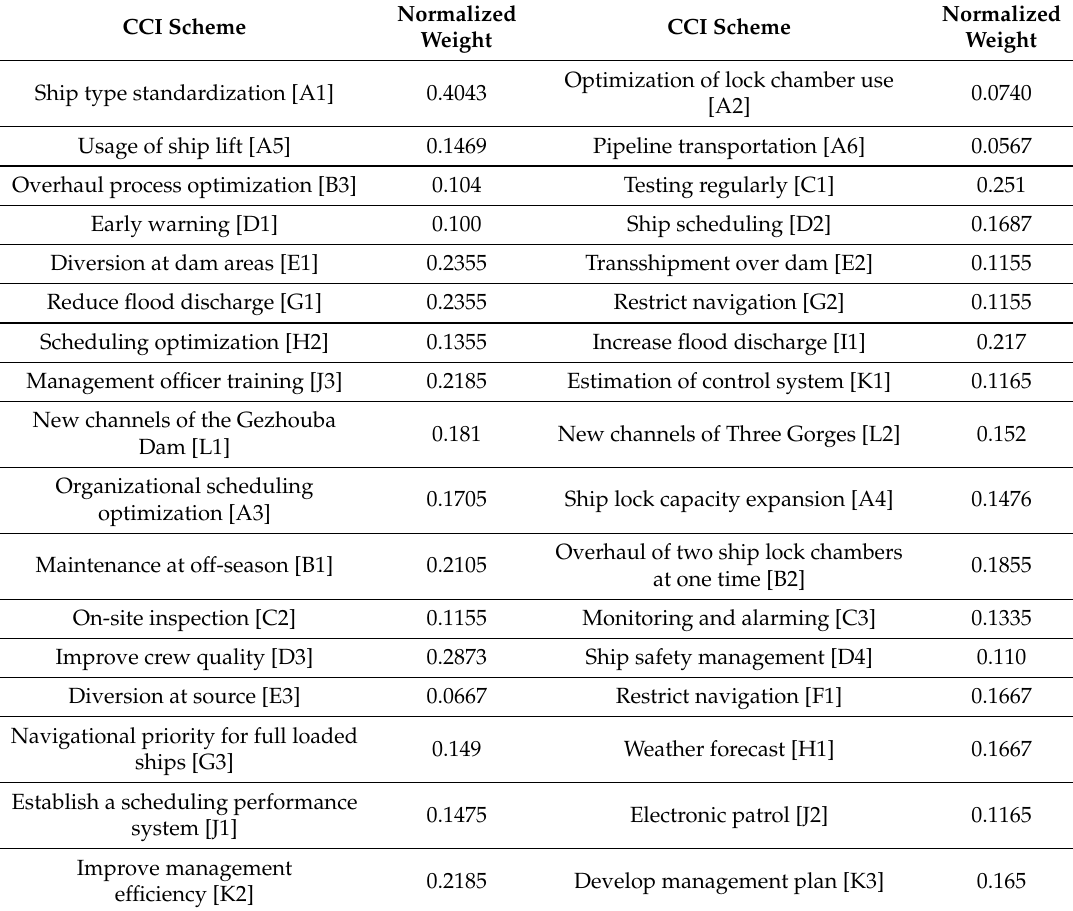
Table 8. Normalized results of